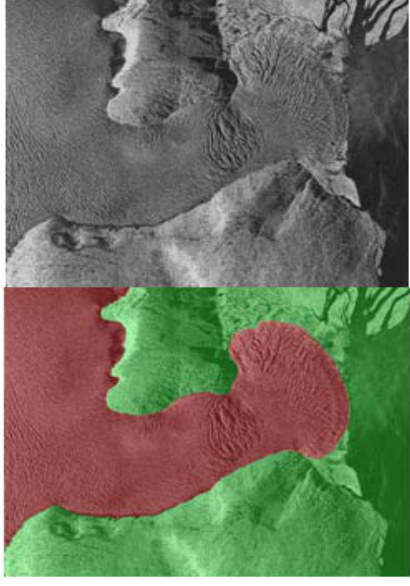
Table 1. TerraSAR-X data delineation used for experiment (SM-stripmap mode)